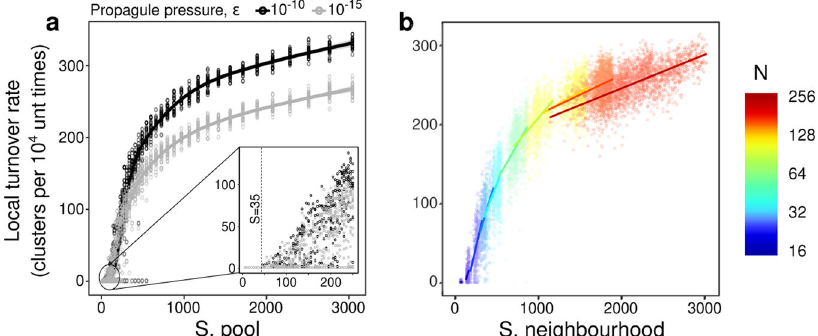
Fig. 4 Ecological mass effects drive autonomous turnover. a The number of compositional clusters detected, plotted against the size of the pool of potential invaders S for an isolated LV community using a propagule pressure ϵ of 10 − 10 and 10 − 15 , fi t by a generalised additive model 87 . For S < 35 a single cluster is detected. For S ≥ 35 autonomous turnover occurs ( ≥ 1 compositional clusters) with the transition indicated by the dashed line (inset). b Qualitatively identical behaviour was observed for model metacommunities in which “ propagule pressure ” arises due to ecological mass effects from the local neighbourhood. Each point represents a single patch. Lines in ( b ) are standard linear regressions. The good alignment of subsequent fi ts demonstrates that neighbourhood diversity is the dominating predictor of cluster number, rather than patch number N . A ij = 0.5 with probability 0.5, ϕ = 10, σ 2 = 0.01, ℓ = 0.5.